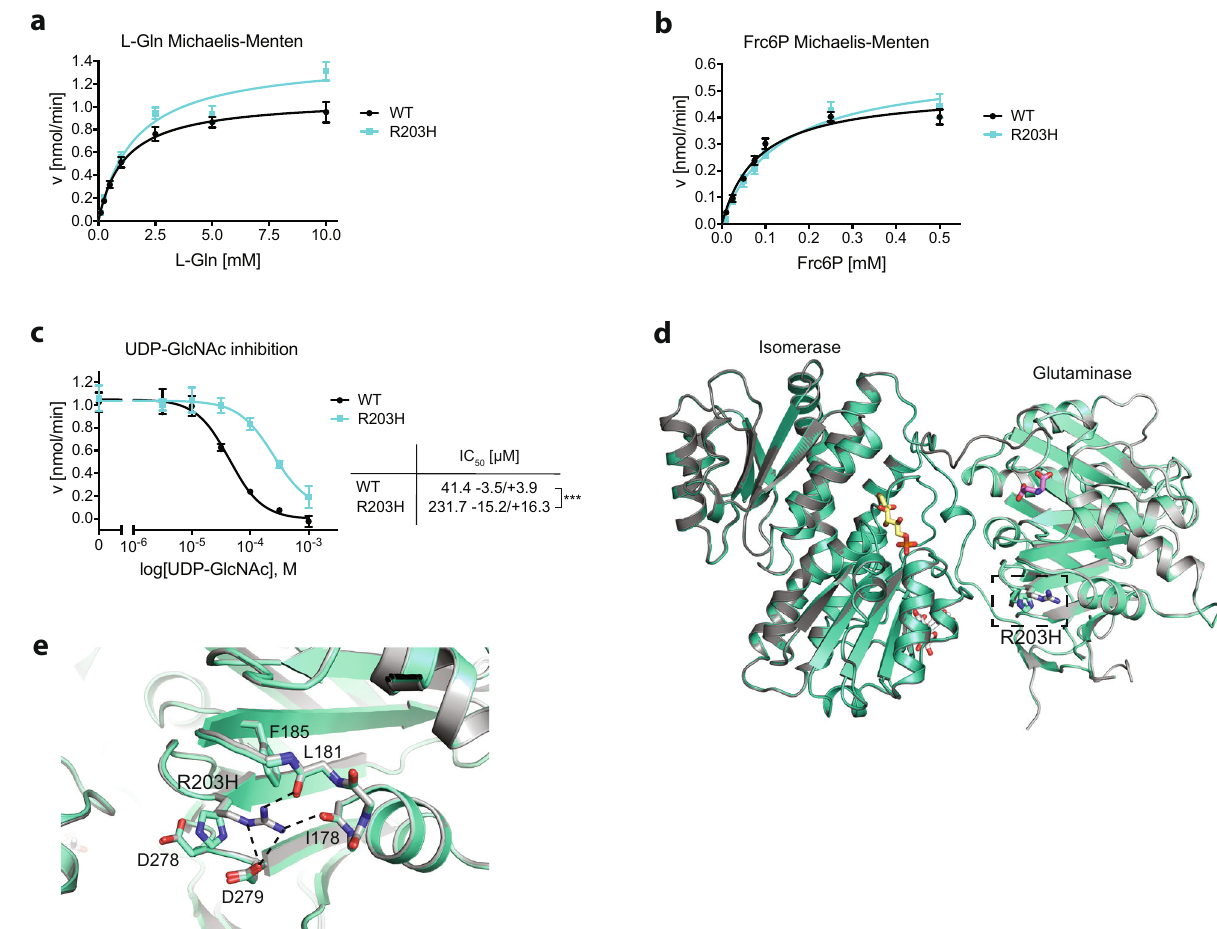
Fig. 2 The GFAT-1 R203H gain-of-function substitution perturbs UDP-GlcNAc feedback inhibition. a L -Gln kinetic of wild type (WT, black circle) and R203H (cyan square) GFAT-1 (mean ± SEM, WT n = 5, R203H n = 4). b Frc6P kinetic of wild type (WT, black circle) and R203H (cyan square) GFAT-1 (mean ± SEM, WT n = 5, R203H n = 4). c Representative UDP-GlcNAc dose response assay of wild type (WT, black circle) and R203H (cyan square) GFAT-1 (mean ± SD, n = 3). Table: IC 50 UDP-GlcNAc values (mean± SEM, n = 4, *** p < 0.0001, unpaired two-sided t test). d , e Position of the R203H mutation in the structure of GFAT-1. Proteins are presented as cartoons. Superposition of wild type GFAT-1 (light gray/dark gray, PDB ID 6R4E) and R203H GFAT-1 (green – cyan, teal) with an RMSD of 0.38 A ̊ over 1280 main chain residues. Glc6P (yellow sticks), L -Glu (violet sticks), and UDP-GlcNAc (white sticks) are highlighted, as well as the position of R203H (black box). d Overview. R203H (sticks) is located at the glutaminase domain of GFAT-1 (dashed box). e Close-up view of the position of R203H focusing on residues in close proximity. The R203H mutation and residues in close proximity to the mutation are highlighted with sticks. Arg203 interacts with the neighboring loops (dashed lines). Source data are provided as a Source Data fi